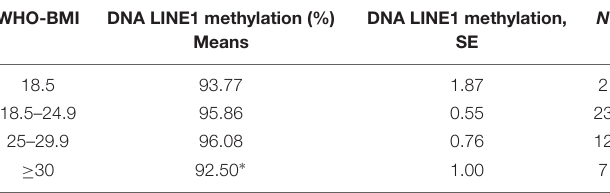
TABLE 2 | LINE-1 methylation in mothers of children with DS with congenital heart defects (CHDs) according to World Health Organization (WHO) body mass index (BMI) category. P -value DS-CHD − DS-CHD + mothers mothers